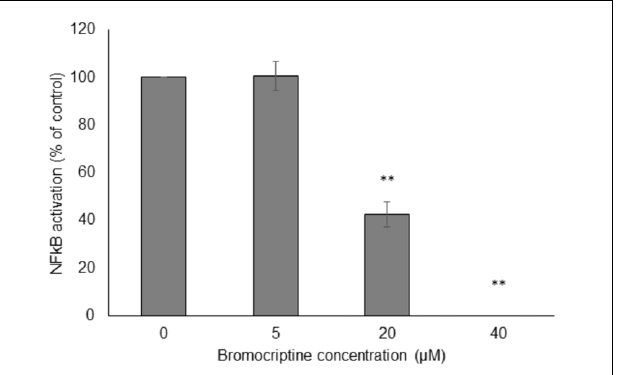
FIGURE 6 | Effect of bromocriptine on NF- κ B activity in reporter cell assays. HEK293 cells stably expressing HEK-Blue-Null1 vector and SEAP on a NF- κ B promoter (Invivogen, San Diego, CA, United States) were used. Significantly different according to Student’s t -test, ∗∗ P ≤